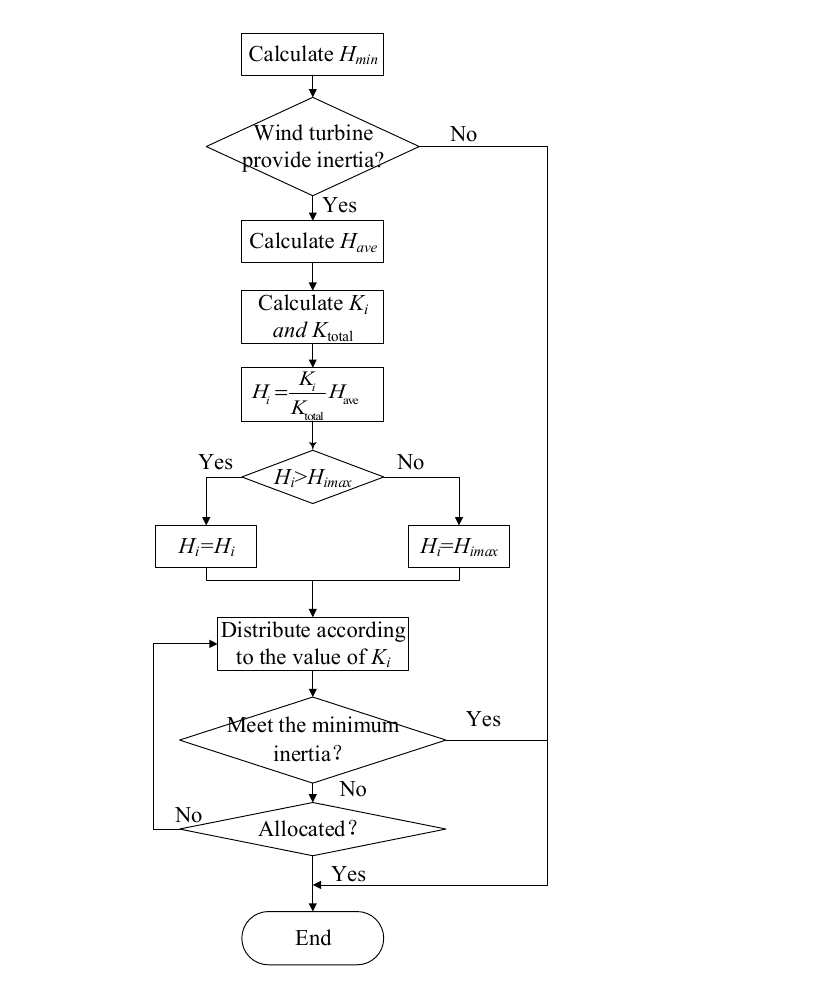
Figure 3. Flow chart of preliminary wind turbine inertia allocation.